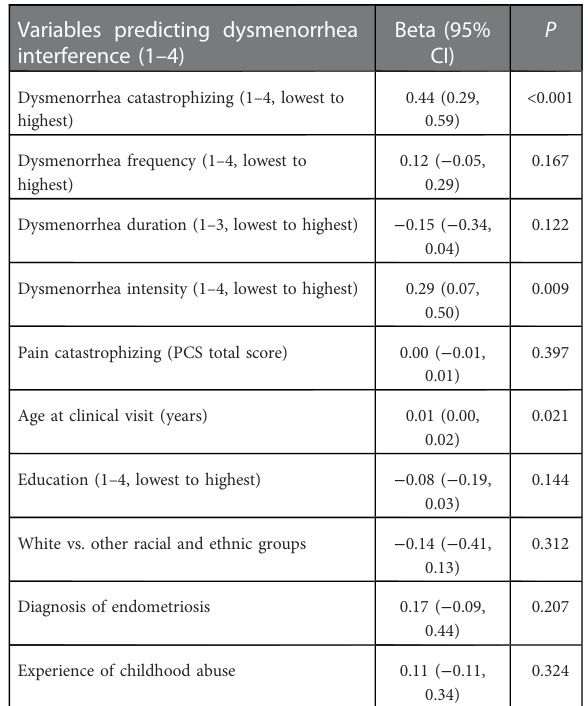
TABLE 5 Multiple linear regression model for the covariates-adjusted association between dysmenorrhea catastrophizing and chronic pelvic pain interference a